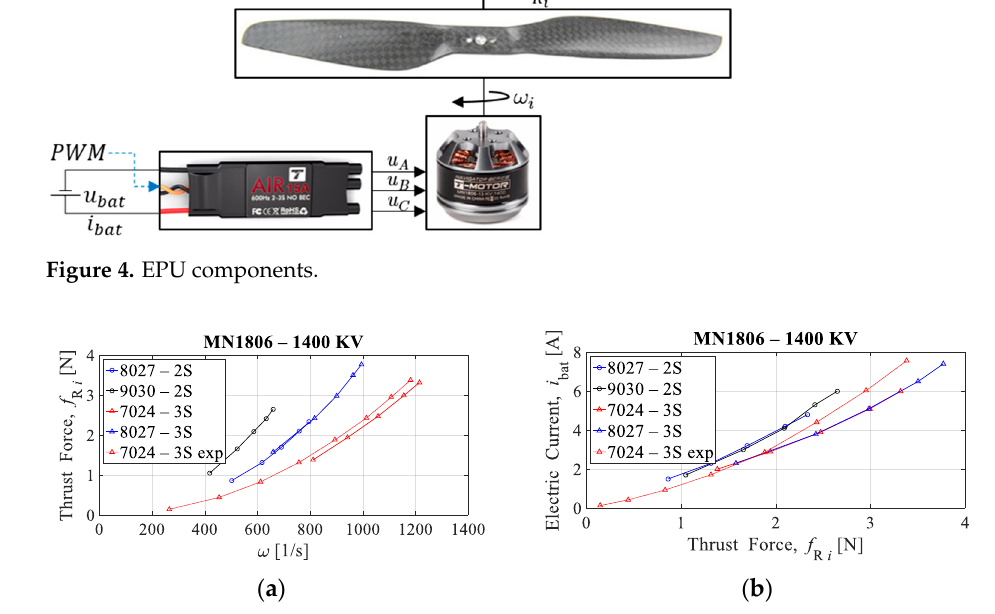
Figure 5. EPU characteristics: ( a ) thrust force as a function of rotor angular velocity; ( b ) electric current as a function of thrust force.